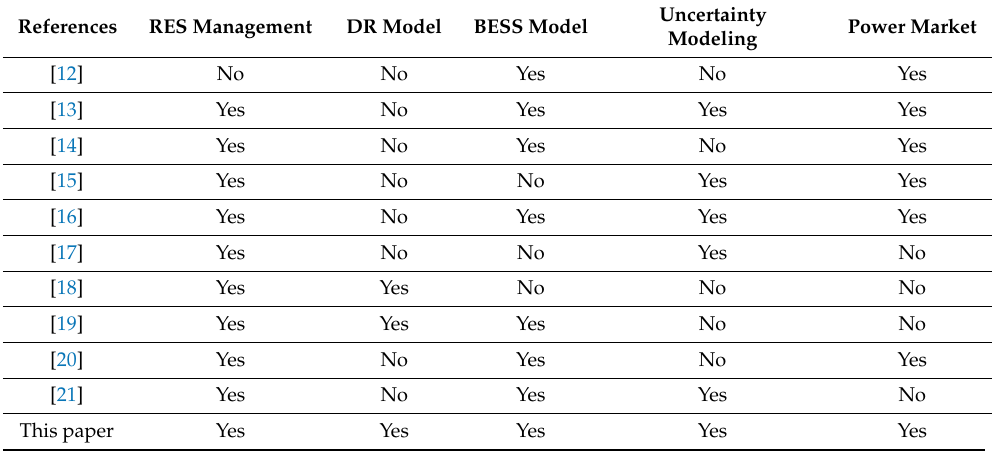
Table 1. Comparison of the proposed method with existing